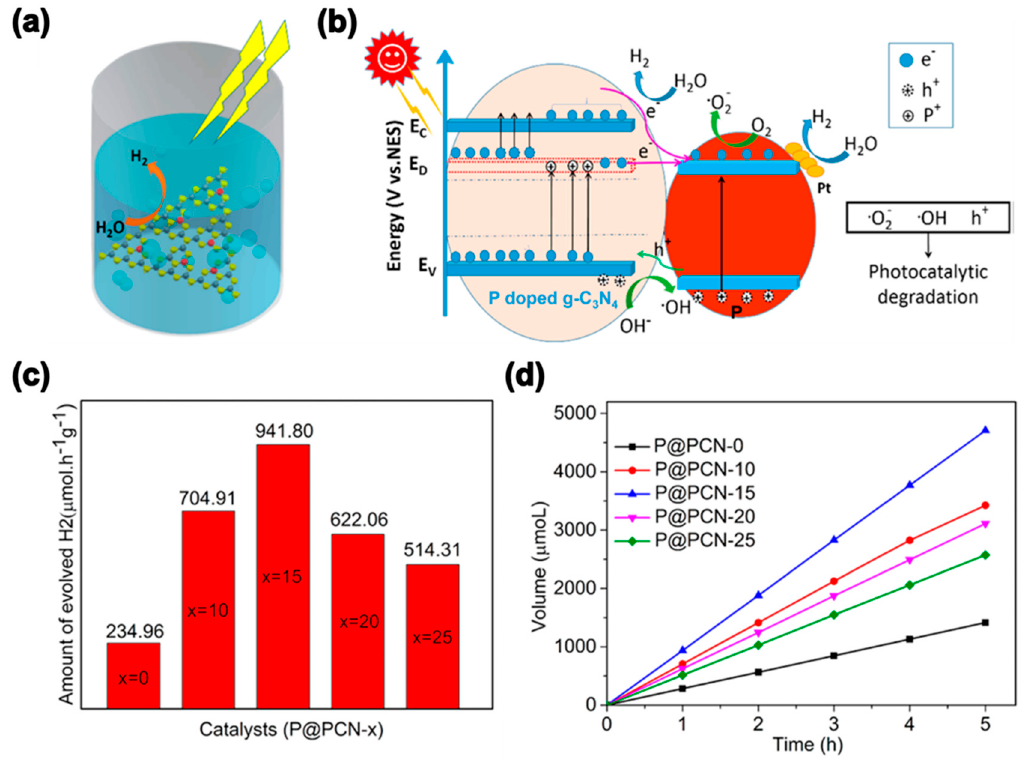
Figure 10. ( a , b ) A schematic of the mechanism of H 2 evolution by the P@P-g-C 3 N 4 catalyst; ( c ) comparison of the evolution rates of H 2 ; and ( d ) H 2 evolution rate of the P@P-g-C 3 N 4 composites. Reproduced with permission from [87]; copyright (2018), American Chemical Society.